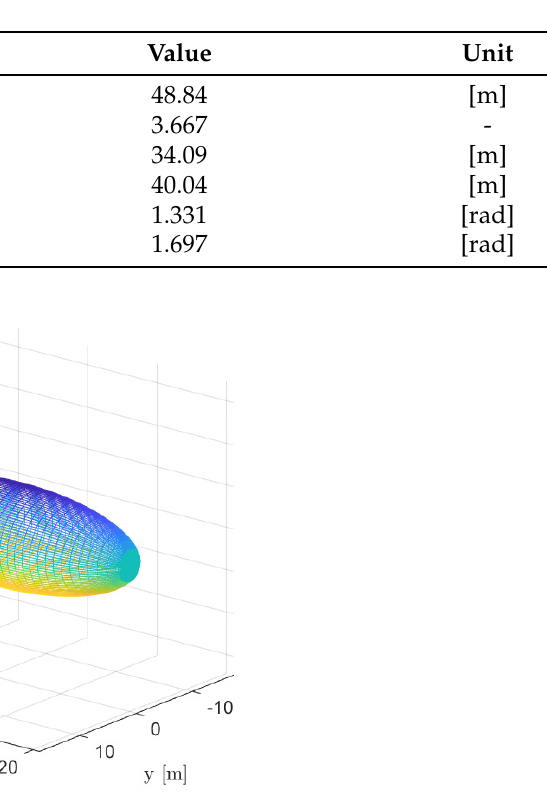
Figure 6. HAPS optimal layout for operation at 20 km altitude above Pontianak, Indonesia.